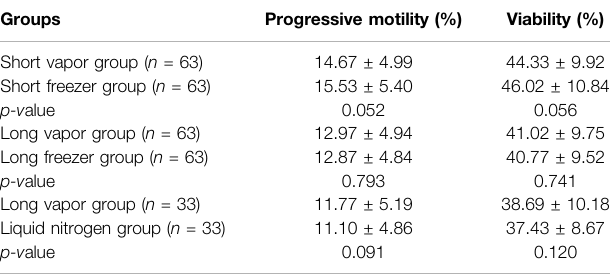
TABLE 2 | Comparison of sperm motility and viability between liquid nitrogen vapor rapid freezing and − 80 ° C freezer. Groups Progressive motility (%)